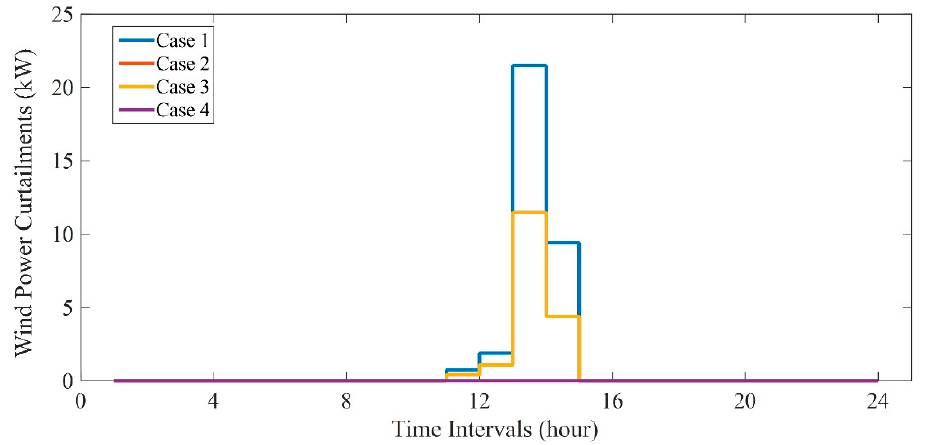
Figure 5. The wind power curtailment in Cases 1–4 on the typical winter day.